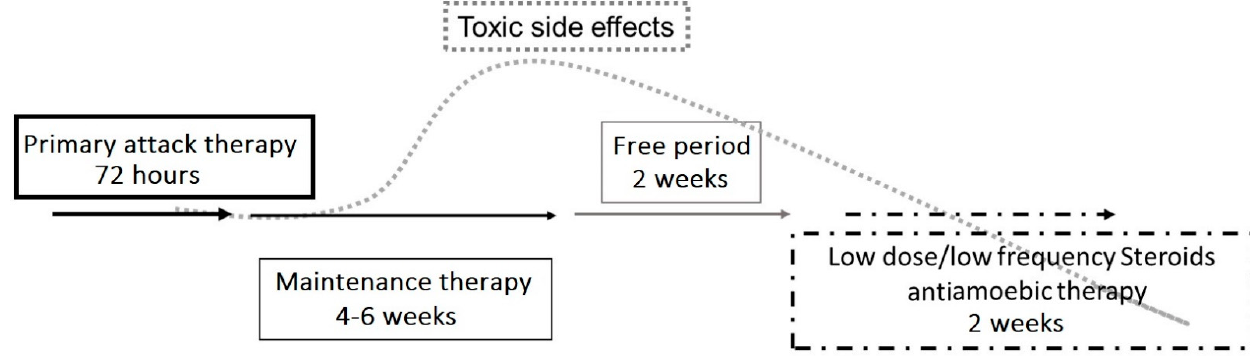
Figure 3. Proposed therapeutic strategy for Acanthamoeba keratitis. An initial aggressive approach to treatment involves hourly topical eye drops (polyhexamethylene biguanide (PHMB) 0.02% and propamidine isethionate 0.1%), followed by tapering to maintenance therapy using PHMB and propamidine 3–4 times per day for 6 weeks. A stable clinical exam after a 2-week antiamoebic free period reduces the risk of medication toxicity and can also unmask the continued presence of trophozoites or cysts. If the infection is still present, the treatment protocol must be repeated. Topical low-dose and low-frequency steroid eye drops (such as loteprednol etabonate and fluorometholone acetate) have been suggested in cases of severe ocular pain, limbitis, or scleritis, and must be used with extreme caution. Topical steroids should only be used with concomitant antiamoebic